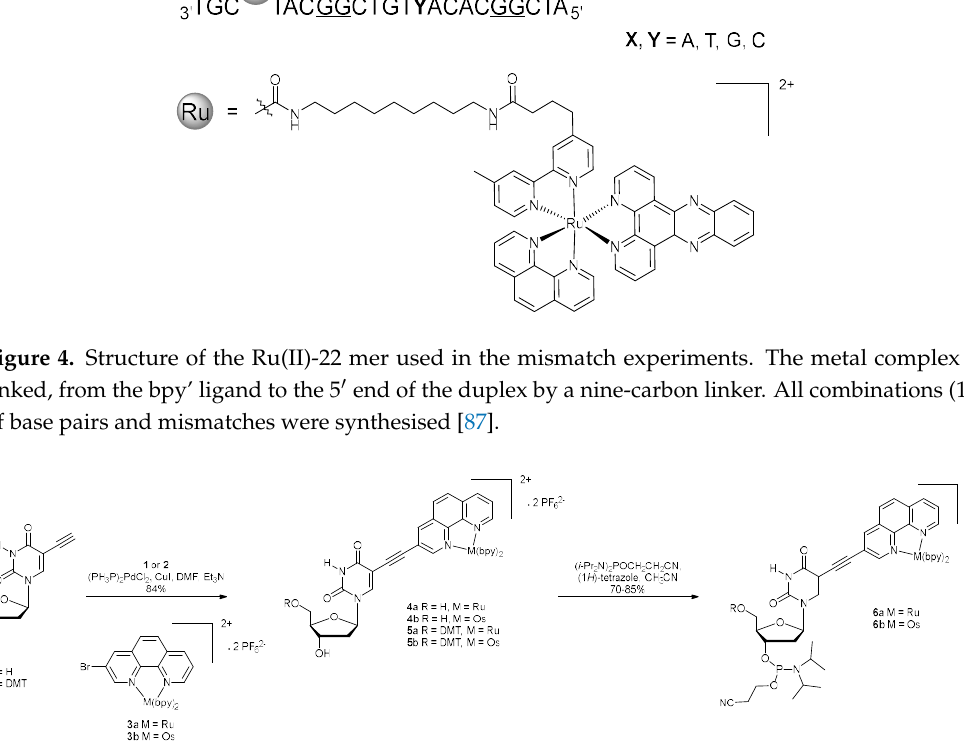
Figure 4. Structure of the Ru(II)-22 mer used in the mismatch experiments. The metal complex is linked, from the bpy’ ligand to the 5’ end of the duplex by a nine-carbon linker. All combinations (16) of base pairs and mismatches were synthesised